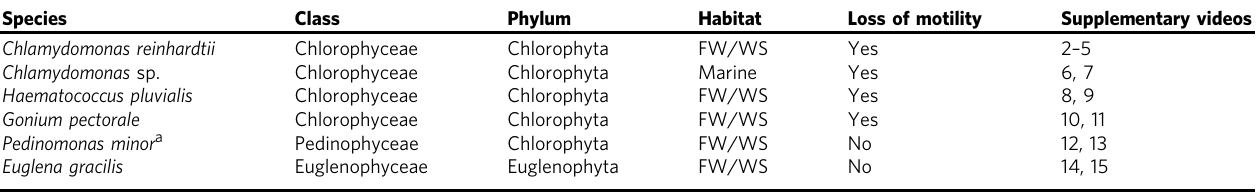
Table 1 Loss of motility of exemplary fl agellate algae upon treatment with orfamide A Species